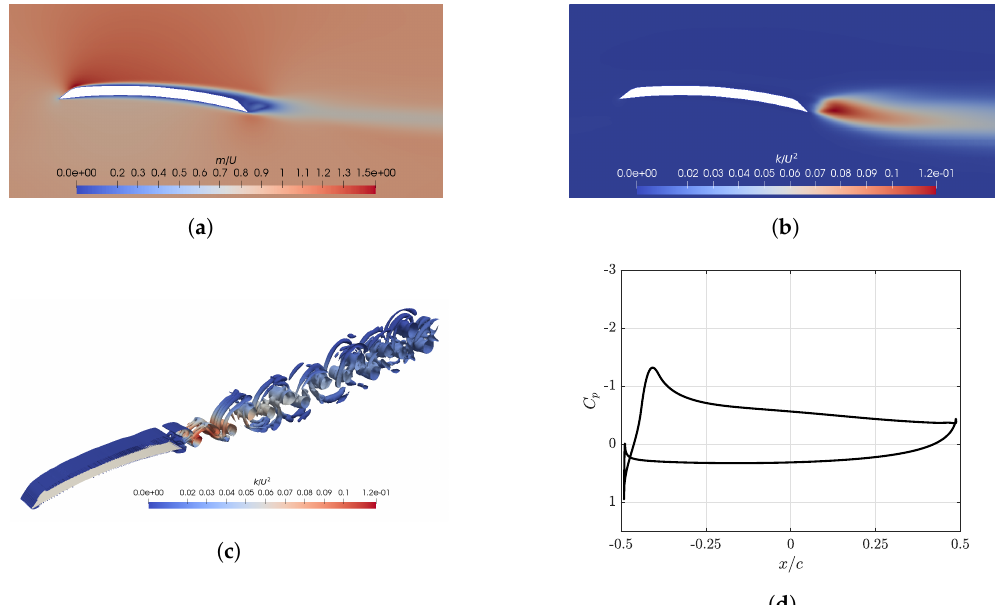
Figure 7. Flow behavior for Re = 10 4 and AoA = 4 ◦ . ( a ) Non-dimensional magnitude of mean velocity m / U ; ( b ) Non-dimensional resolved turbulence kinetic energy k / U 2 ; ( c ) Isosurface of the non-dimensional resolved second invariant of velocity gradient ˜ Q · c 2 / U 2 = 1 colored by the non-dimensional resolved turbulence kinetic energy k / U 2 ; ( d ) Pressure coefficient C p